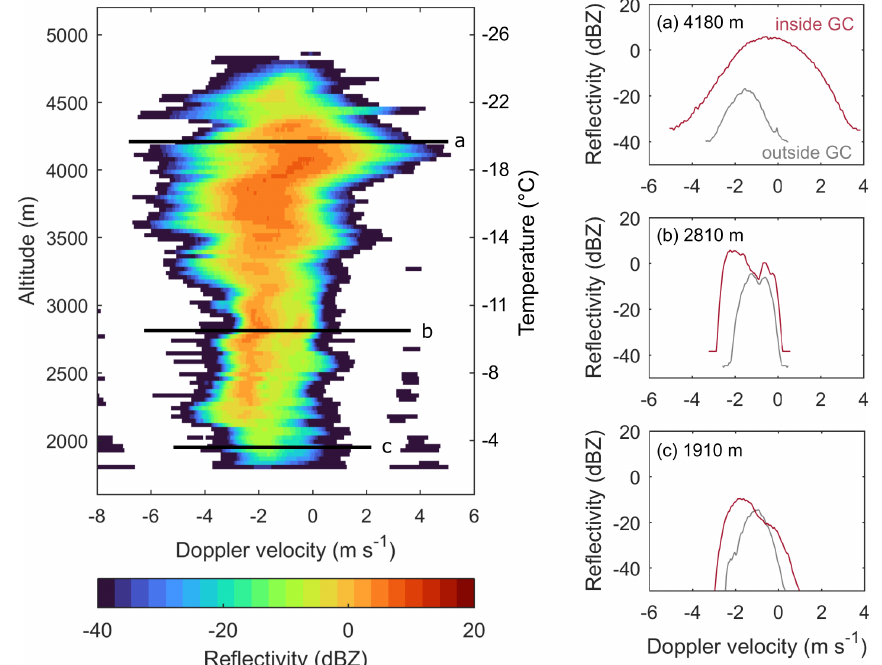
Figure 9. Vertical profile of the Doppler spectra along the 17:00UTC fallstreak averaged over 1min (indicated by black line in Fig. 8a). The Doppler spectra at three selected heights are shown on the right: 4180m (within turbulent layer), 2810m (at mountain barrier height) and 1910m (at balloon flight height). The red line indicates the Doppler spectrum inside the 17:00UTC fallstreak (GC in ), whereas the gray spectrum was measured before the fallstreak (GC out in Fig. 8a).